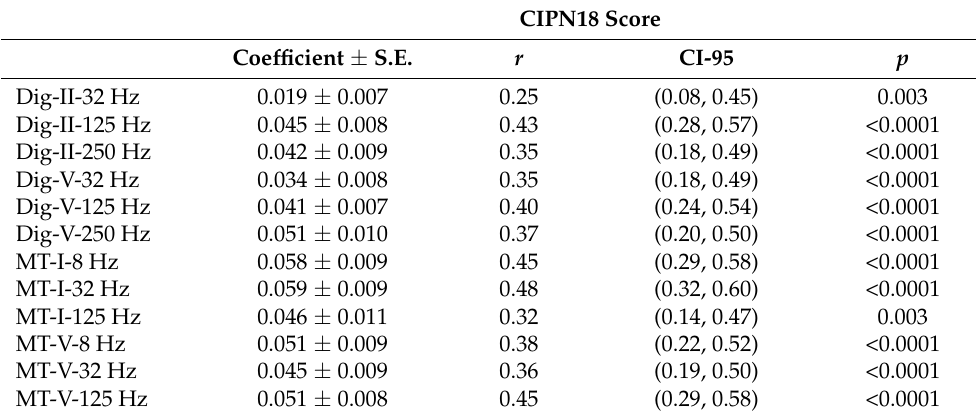
Table 3. Estimated magnitude of linear relationship and correlation between MF-V frequencies and patient-reported outcomes